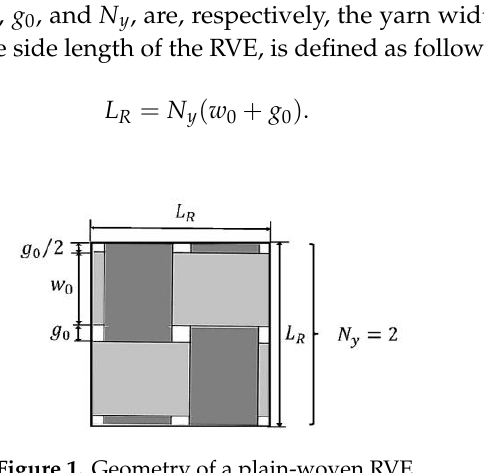
Figure 1. Geometry of a plain-woven RVE.